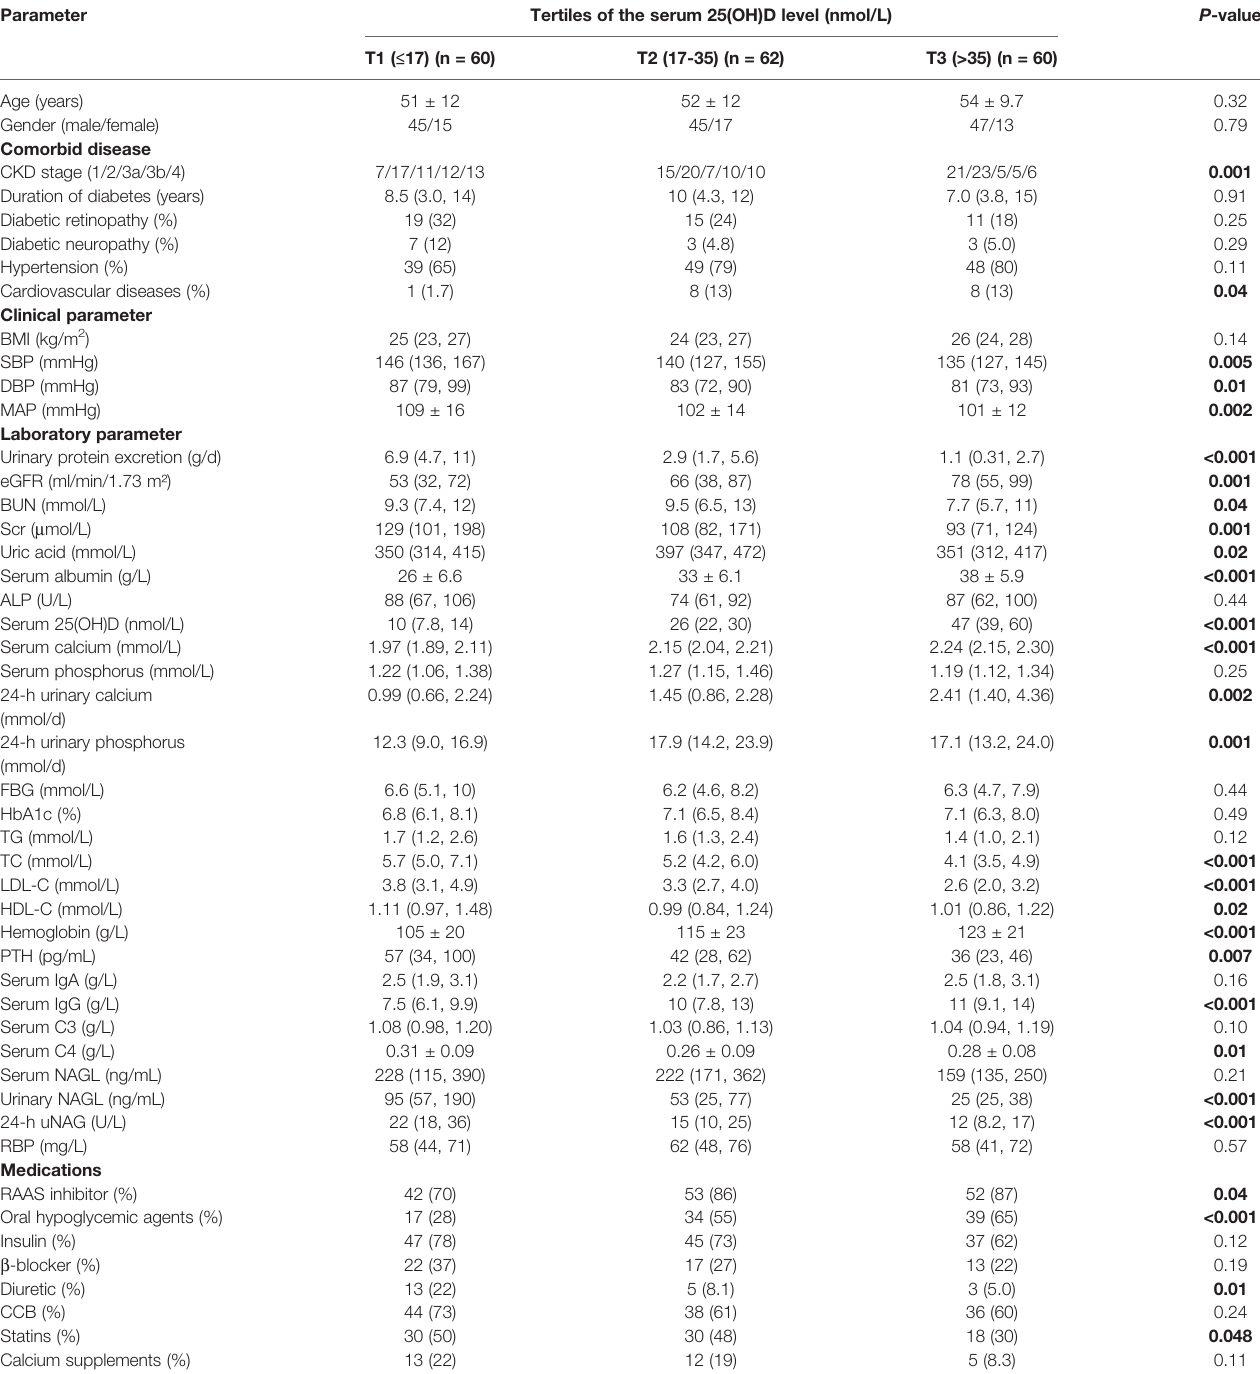
TABLE 2 | Clinical characteristics and laboratory fi ndings of all enrolled patients according to tertiles of vitamin D level. Parameter Tertiles of the serum 25(OH)D level